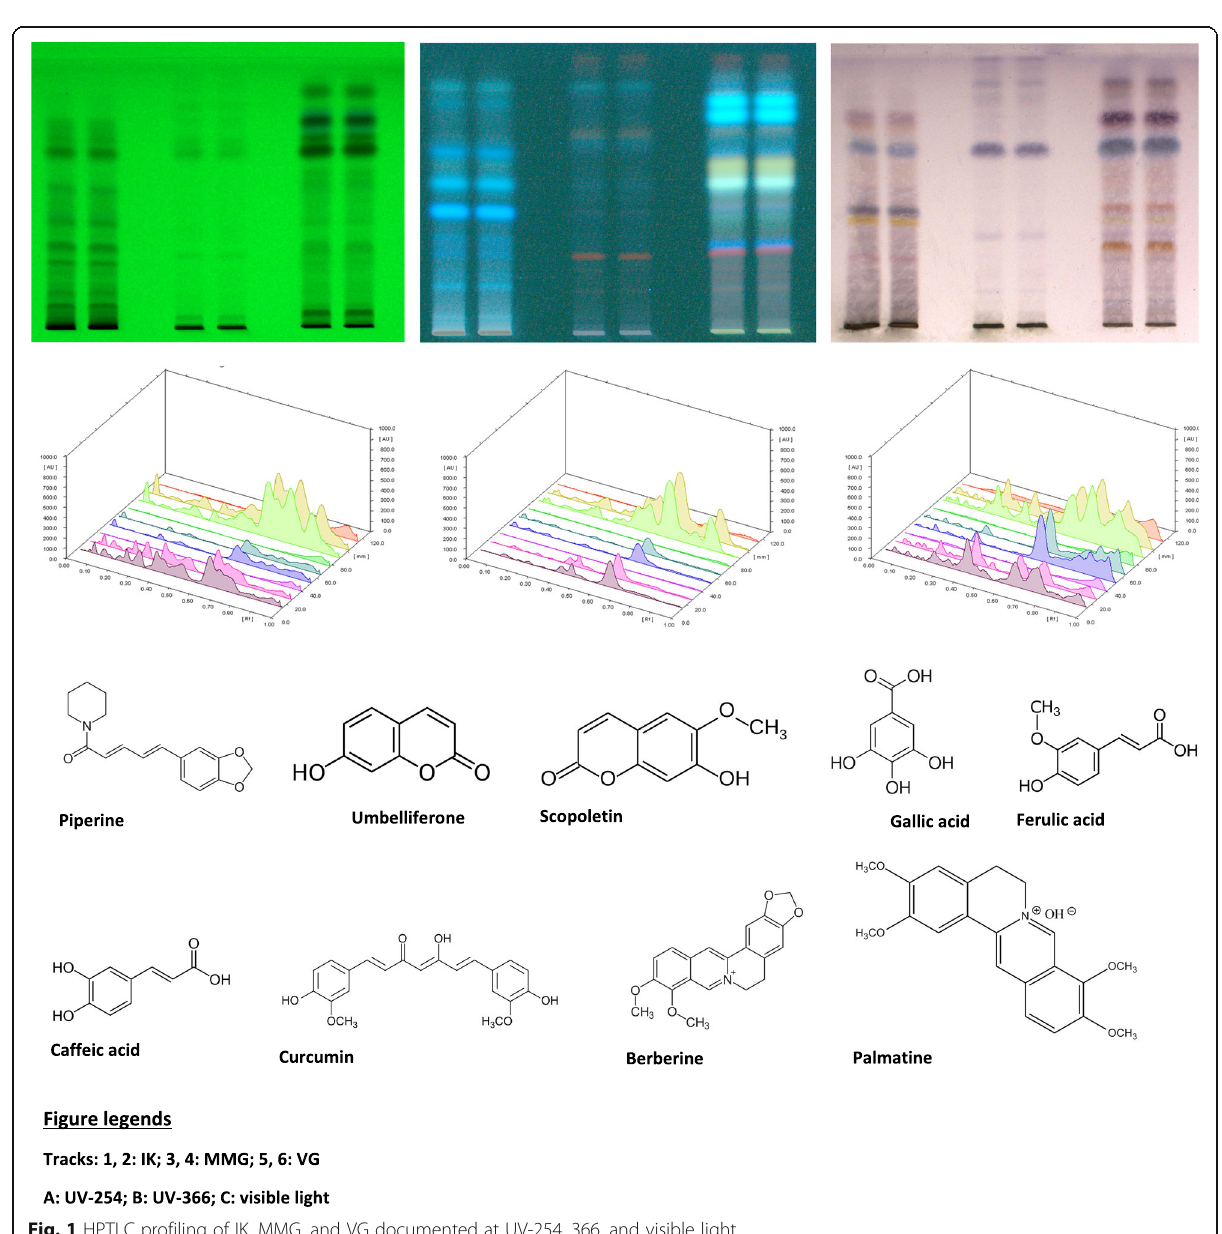
Fig. 1 HPTLC profiling of IK, MMG, and VG documented at UV-254, 366, and visible